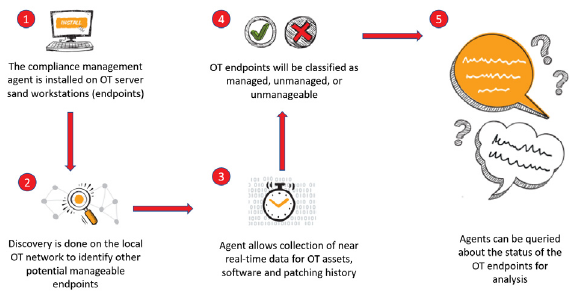
Figure 12. Endpoint compliance management overview.